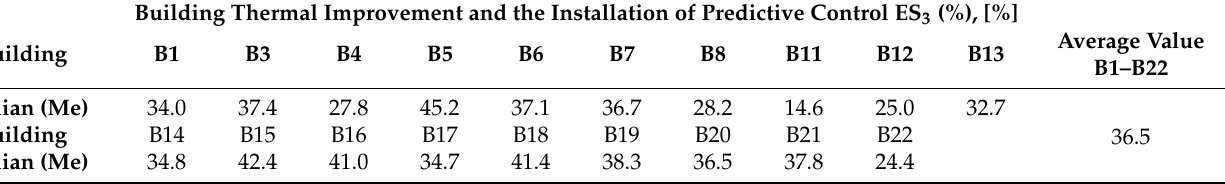
Table 11. Energy savings after thermal improvement and introduction of Egain Edge system ES3 (%), [%].